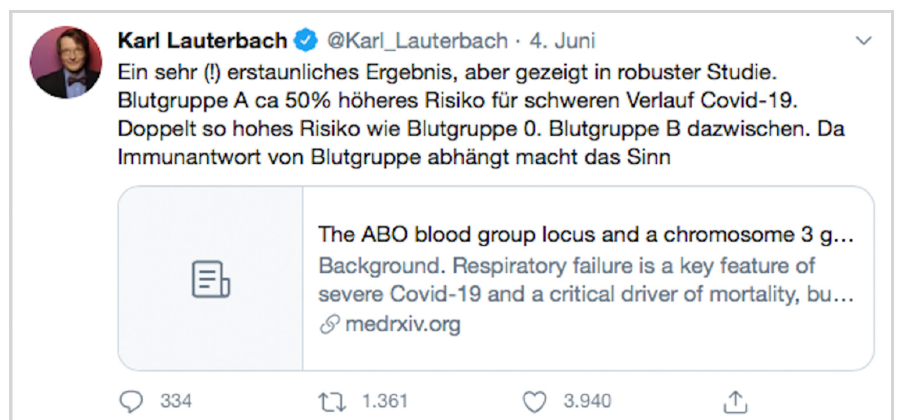
Figure 1. Tweet by German health professional and politician Karl Lauterbach addressing the preprint. [A very remarkable result shown in a robust study. Blood group A about 50% higher risk for severe course of COVID-19. Risk twice as high as with blood group 0. Blood group B in between. Because immune response depends on the blood group it makes sense] . (https://twitter.com/Karl_Lauterbach/ status/1268522737573728257 , translated from German). Permission to reproduce this tweet was obtained from Karl Lauterbach’s